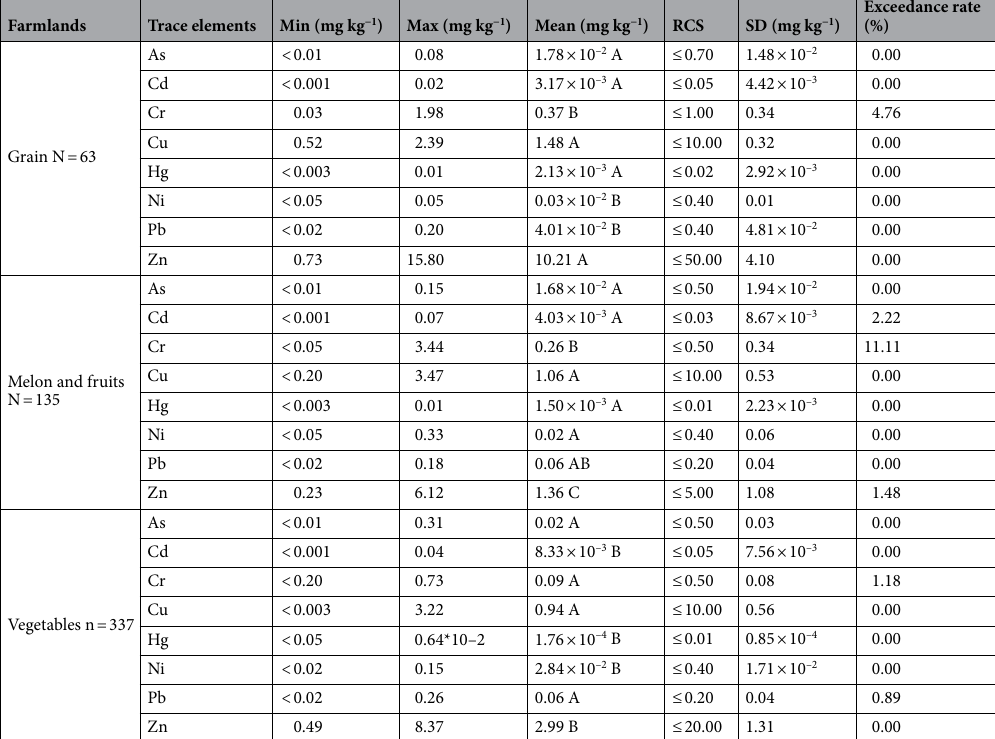
Table 3. Statistical analysis of eight trace elements in three crops. The different capital letters after the Mean values indicate a significant difference ( p < 0.05) in trace element content or soil properties among the three farmlands using One-way ANOVA, whereas same capital letters show no significant differences ( p > 0.05). Risk Control Standard (RCS) is regulated by the China Health Ministry (supporting information Table